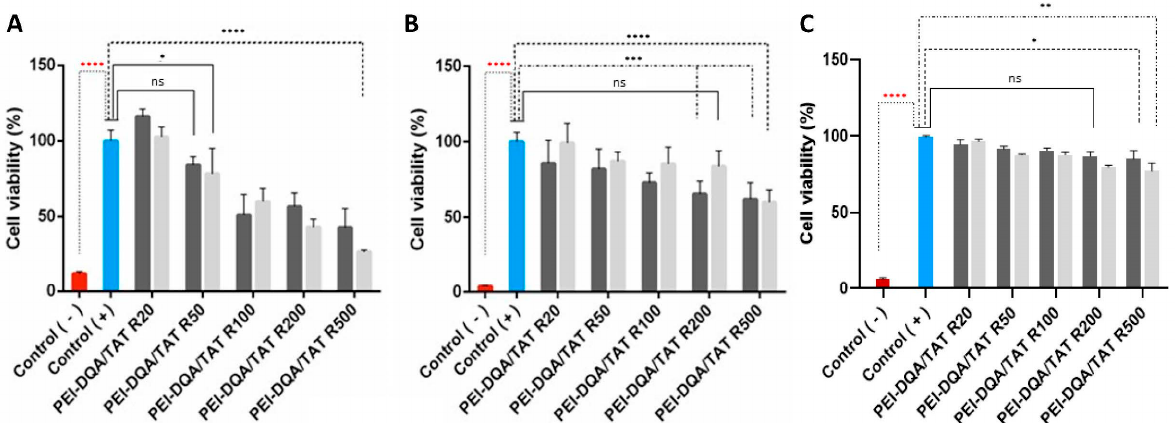
Figure 9. Cellular viability of HeLa cells after 24 h ( A ), 48 h ( B ), and 72 h ( C ) of incubation with PEI–DQA (10 kDa or 25 kDa)/TAT/pND1 complexes conceived at N/P ratios of 20:2:1, 50:2:1, 100:2:1, 200:2:1, and 500:2:1. Non-transfected cells were used as positive controls (100 % viability) and ethanol-treated cells were considered as negative controls (0 % viability). Statistical analysis was carried out using “one-way ANOVA” with data obtained from four independent measurements (mean ± SD, n = 4).